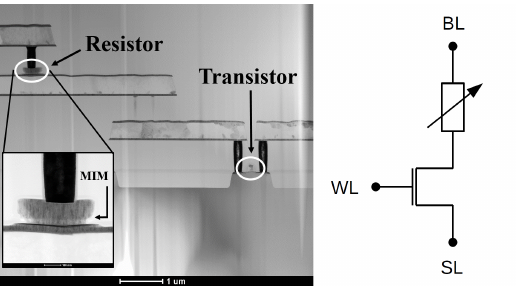
Figure 2. Cross-sectional TEM image of the 1T-1R structure and of the MIM stack in more detail ( left ). Schematic of the 1T-1R cell ( right